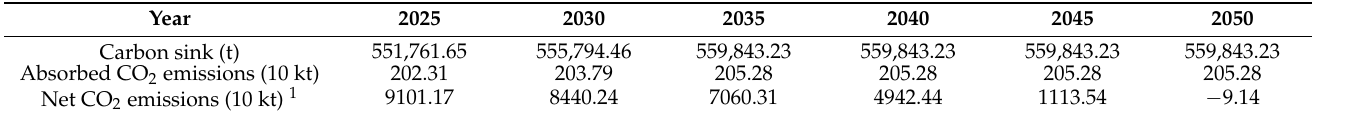
Table 4. Prediction of carbon sink in